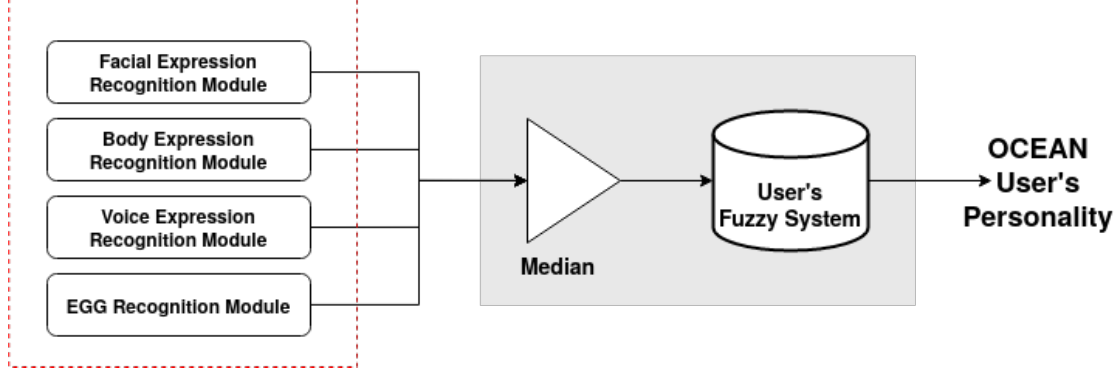
Figure 3. Module 01-responsible for inferring the user’s